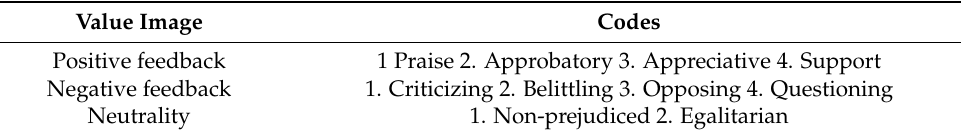
Table 2. Codes of value images of female medical